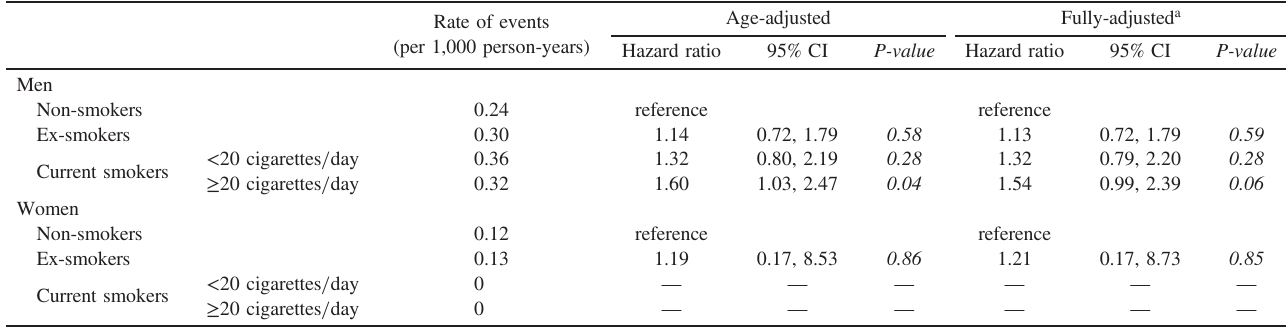
Table 2. Hazard ratios of tra ffi c accident death according to participant smoking